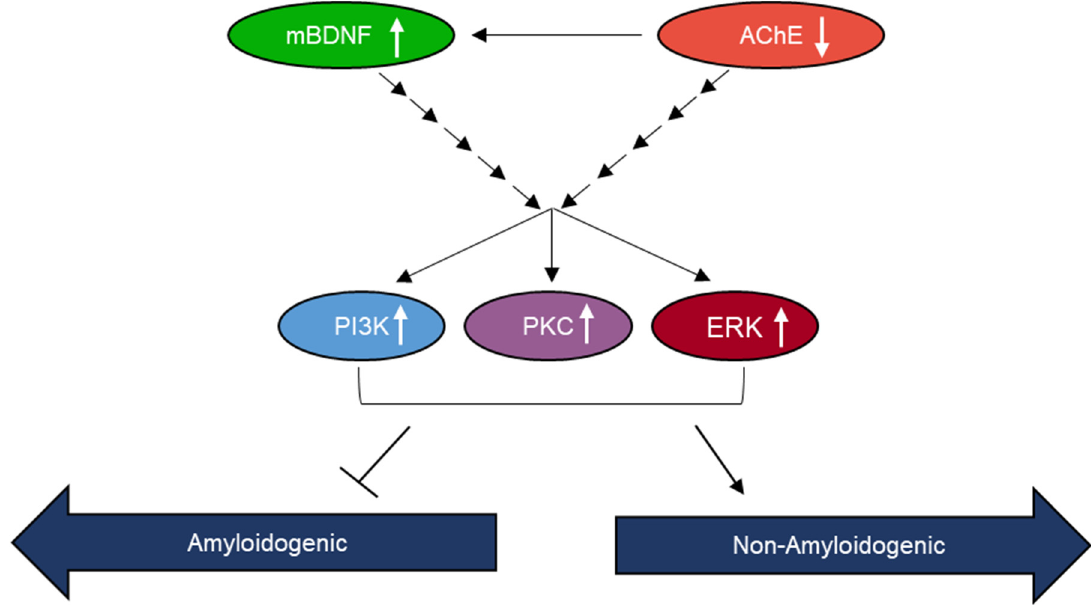
Figure 10. Representation of the main hypothesis and findings of this study.